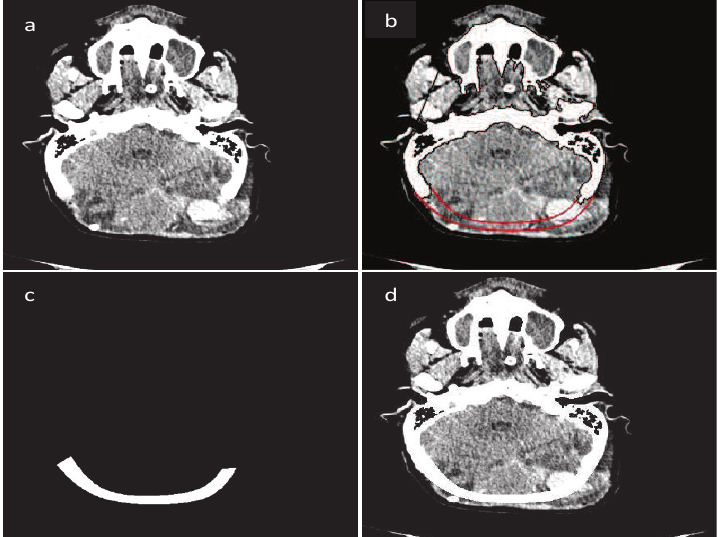
Figure 8. Construction of fractured part using B-spline. ( a ) Original CT scan image; ( b ) Construction of fractured part boundary curves; ( c ) Fractured part in DICOM format; ( d ) Implanted fractured